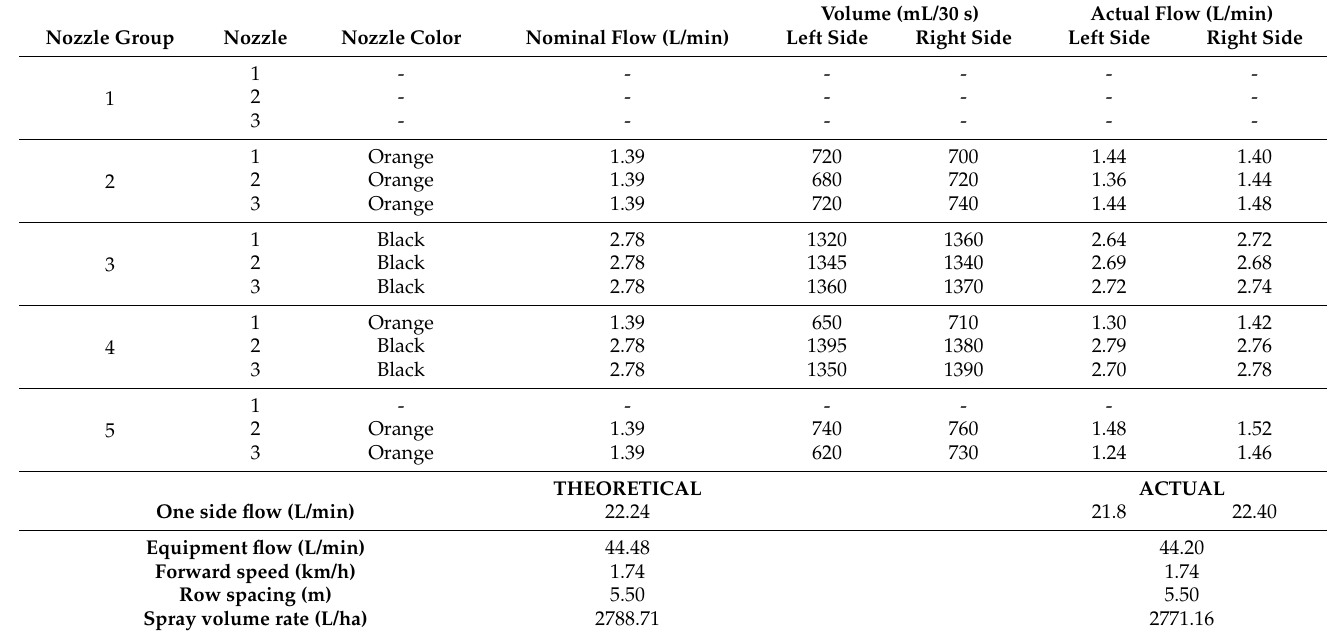
Table A3. Selection and calibration of nozzles for the T sprayer, with the following configuration: Adjusted to the vegetation/High & Low fan speed/High spray volume rate/Conventional nozzles (Fine)/Pressure: 10 bar.